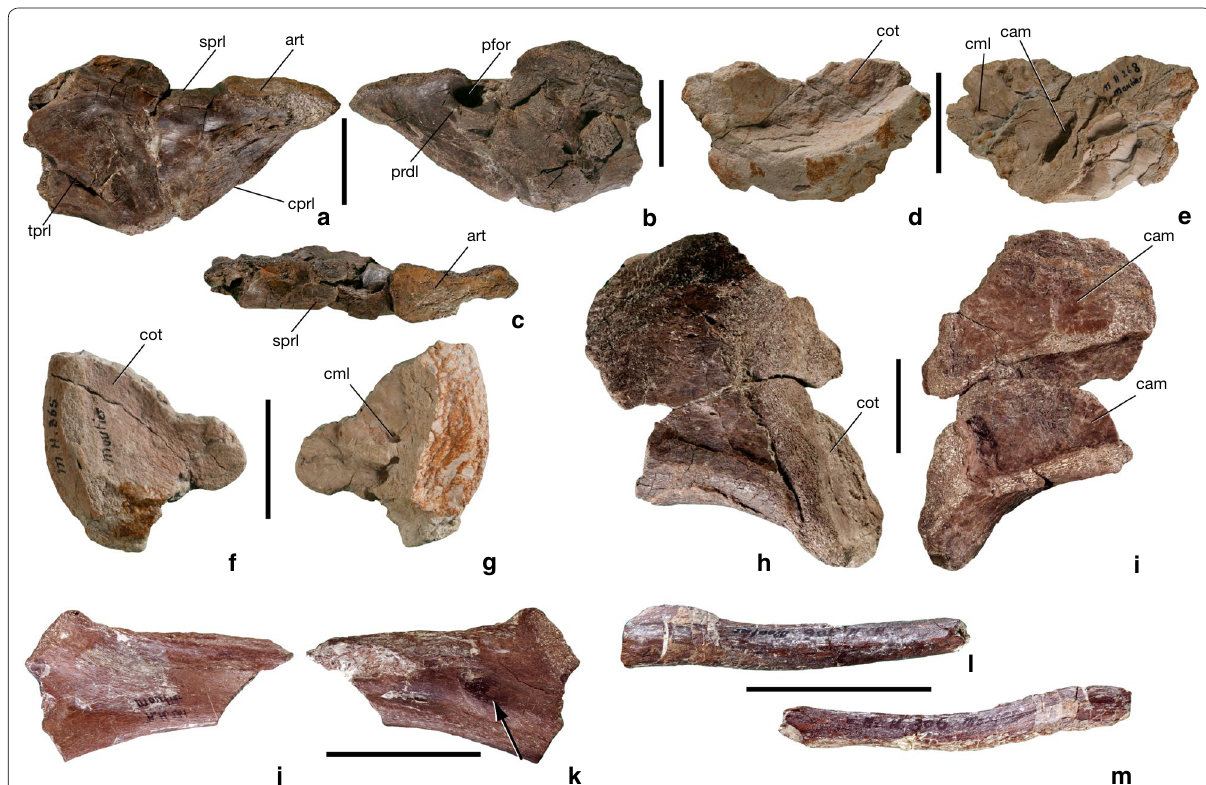
Fig. 6 Isolated left cervical prezygapophysis NMB M.H. 266 of A. greppini . a medial, b lateral, c dorsal aspect. Isolated vertebral cotyla NMB M.H. 268 d posterior and e anterior aspect. Isolated vertebral cotyla NMB M.H. 365 f posterior and g anterior aspect. Fragmentary dorsal vertebral centrum NMB M.H. 299 h lateral, i medial aspect. Scale bar for a – i is 30 mm. Dorsal rib fragment NMB M.H.291 j in lateral and k medial aspect, arrow shows concavity on anteromedial face of the rib head. Posterior dorsal rib fragment NMB M.H. 306 l in lateral and m in medial aspect. Scale bar for j – m is 50 mm. art articular surface, cam pneumatic camera, cml pneumatic camella, cot vertebral cotyle, cprl centroprezygapophyseal lamina,